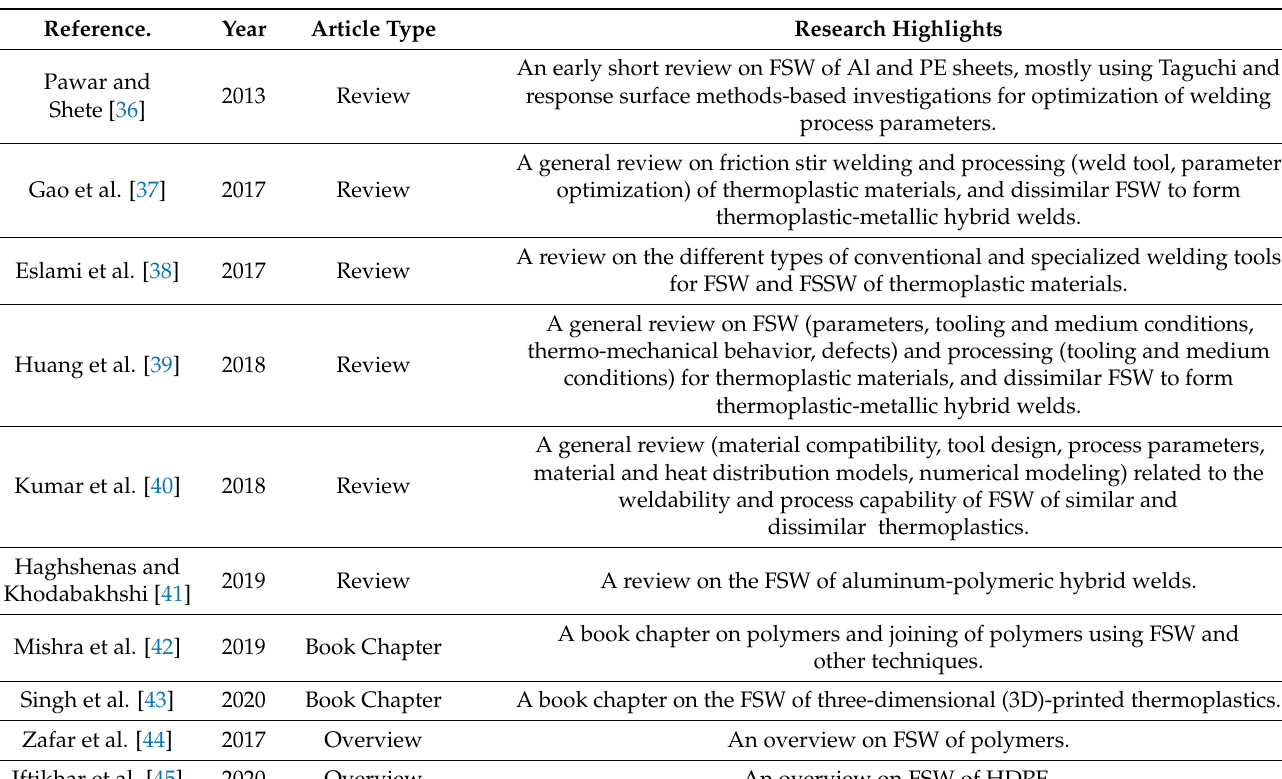
Table 1. Research highlights of review articles and book chapters from the literature.